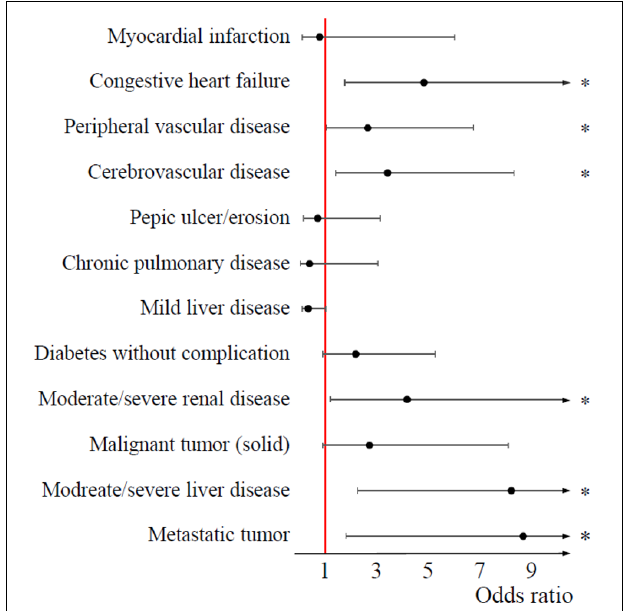
FIGURE 4 | Forest plot on the effect of individual comorbidities on mortality. 95% confidence intervals did not cross the boundary of significance (red, vertical line at an odds ratio of (1) regarding six comorbid conditions: congestive heart failure, peripheral vascular disease, cerebrovascular disease, moderate/severe renal disease, moderate/severe liver disease, and metastatic tumor (asterisks indicate a p -value less than 0.05). These comorbidities were associated with higher